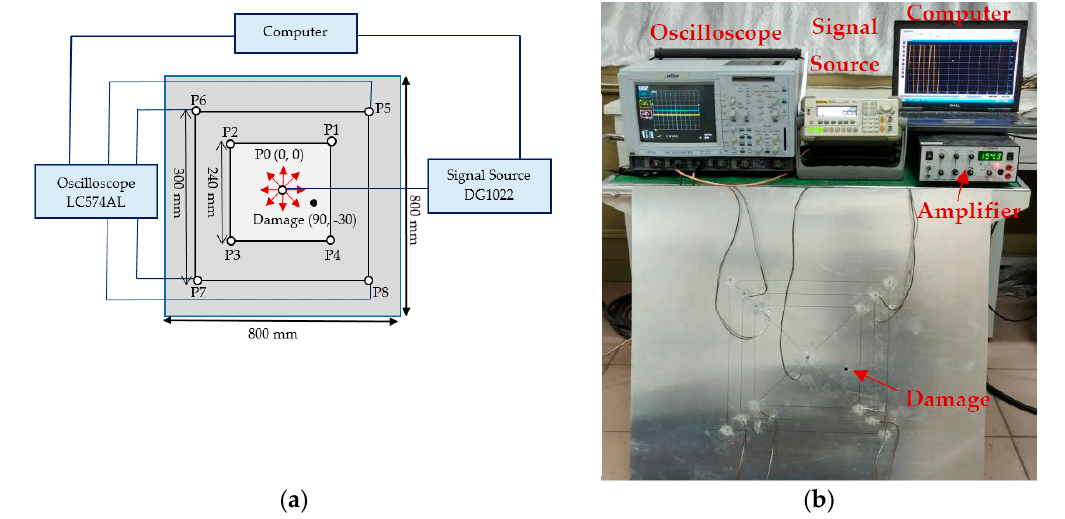
Figure 17. Experimental setup: ( a ) schematic diagram and ( b ) laboratory diagram.